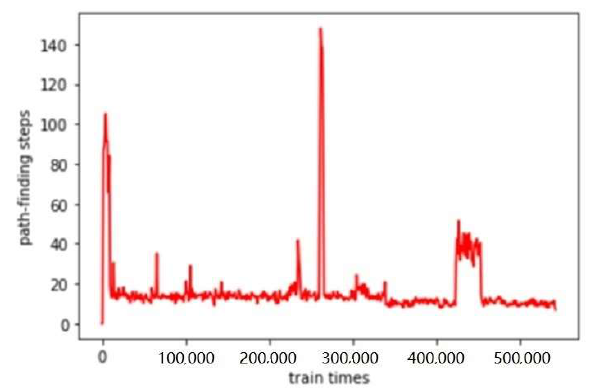
Figure 5. Average path-finding step learning curve.